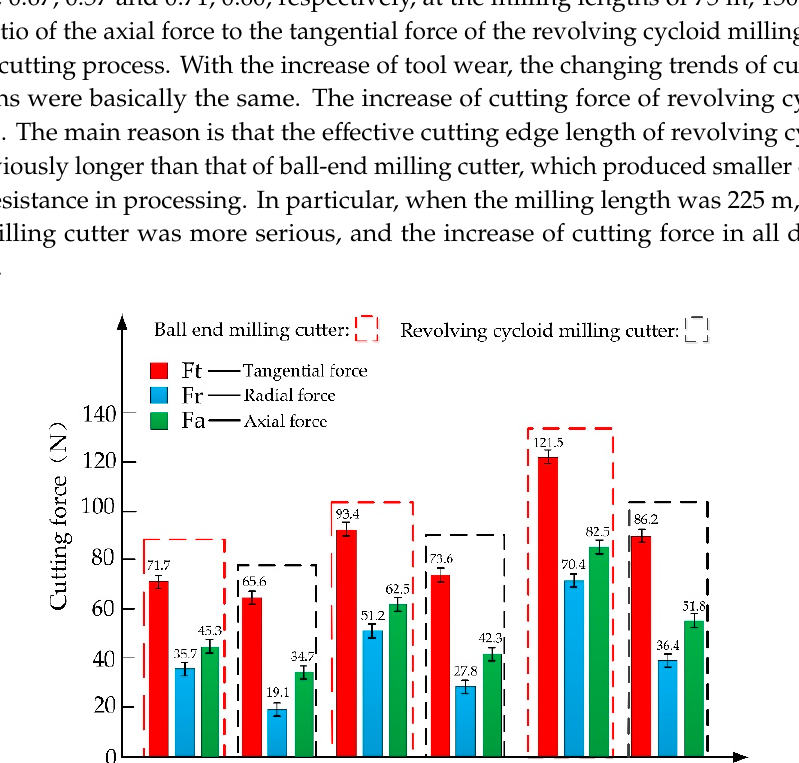
Figure 11. Cutting performance test layout.